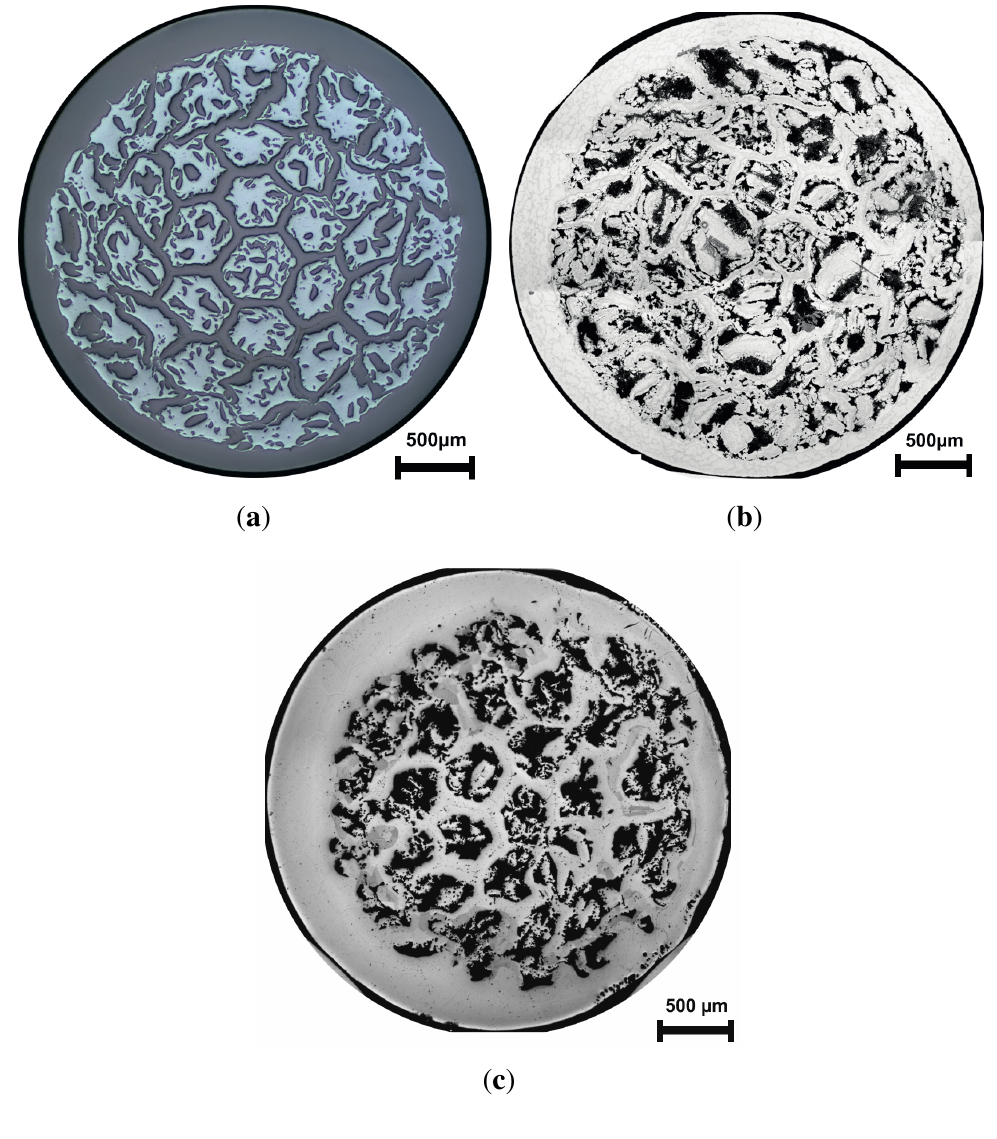
) and ( c ) wire ( b ) with additional heat 3 Al + γ - 3